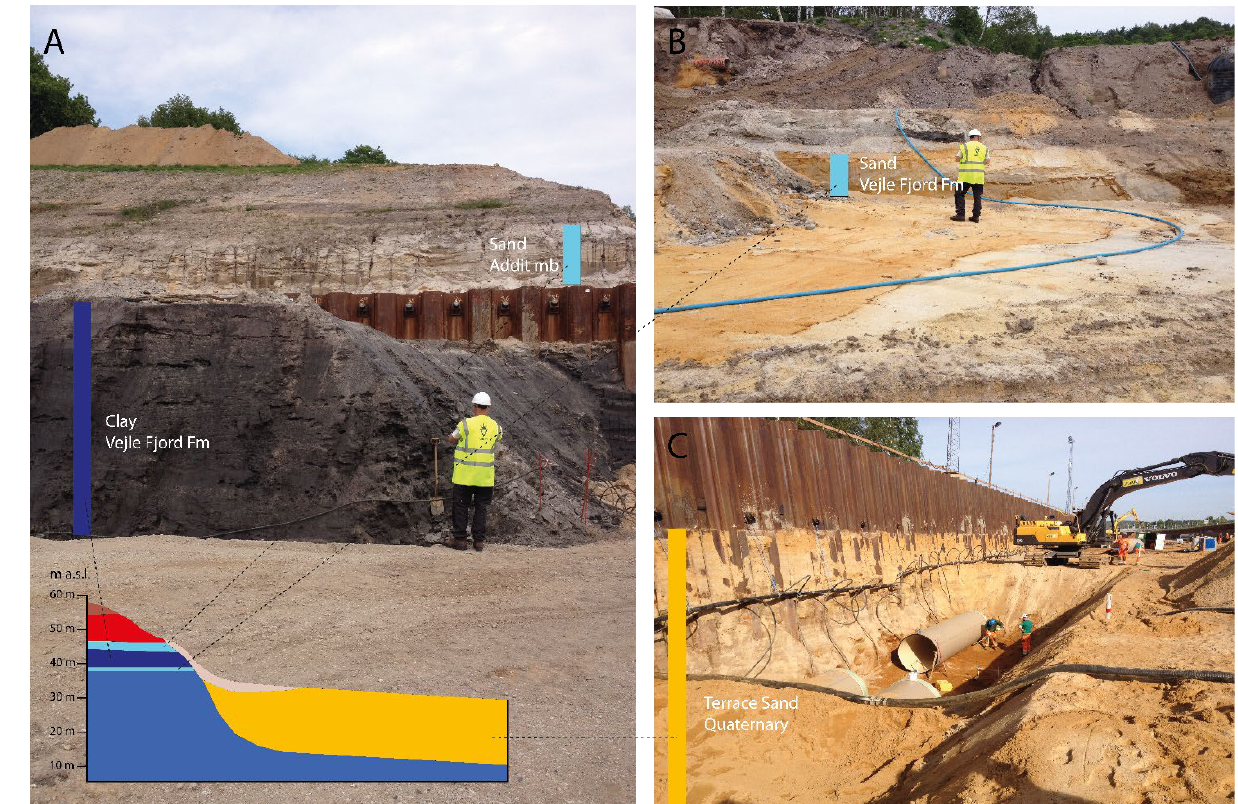
Figure 3. Post auditing the geological model on site. Sheet piling is visible in ( A , C ). Miocene sand from the Vejle Fjord Fm ( B ) During construction, the groundwater table was lowered in several sections along the motorway with a suction cell system at the sheet piling, with suction cells every 1 m connected to larger pumps, picture ( C ).